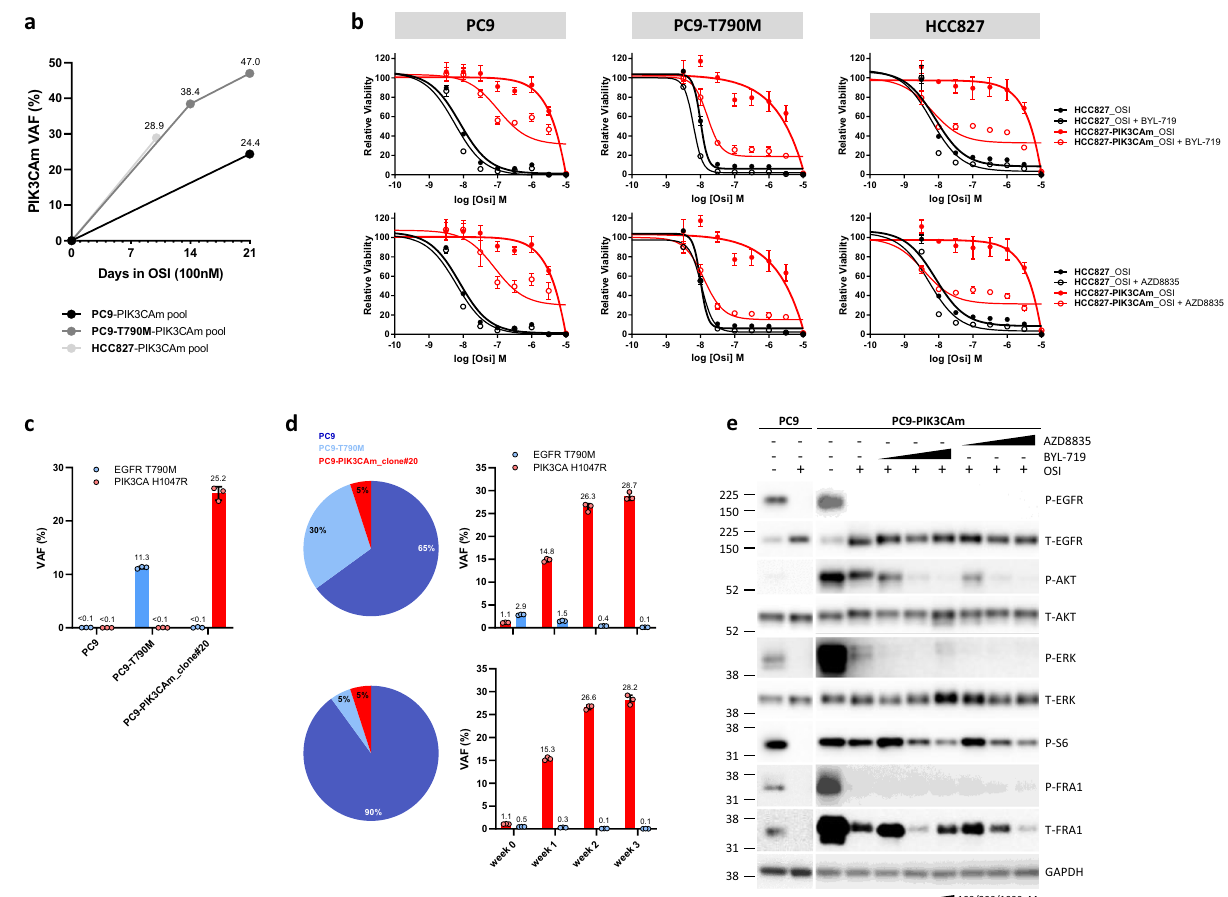
Fig. 5 In vitro functional analysis of the PIK3CA H1047R mutation (PIK3CAm) detected in multiple baseline plasmas from AURA3 patients. a Dynamics of PIK3CA H1047R VAF changes in individual CRISPRed cell lines treated with 100nM osimertinib for 2 – 3 weeks. The HCC827 – PIK3CAm pool was treated for 2 weeks (DNA analysis at day 10), the other two cell line pools were treated for 3 weeks. DNA from PC9 – PIK3CAm pool was assessed by NGS, the other two cell line pools were genotyped by ddPCR. PIK3CAm refers to PIK3CA H1047R. b Effect of osimertinib and 500nM PI3K pathway inhibitor (BYL-719, AZD8835) co-treatment in the PIK3CA H1047R mutant cell pool and PIK3CA WT parental cell lines grown in 2D monolayer. Parental cell lines PC9, PC9- T790M and HCC827 were tested. Representative experiments from three independent repeats are shown, error bars represent mean±SD from replicate wells. c EGFR T790M and PIK3CA H1047R genotyping in three cell line models used in a co-culture experiment: PC9, PC9-T790M (EGFR T790M VAF = 11.3 ±0.212%), PC9-PIK3CAm_clone#20 (PIK3CA H1047R VAF = 25.2±1.272%). Black lines and error bars represent the mean±SD VAF (%) from three independent ddPCR runs with optimised conditions for each ddPCR assay. The mean VAFs where values are not speci fi ed were <0.1%. d Pie charts (left panel) show the percentage of each cell line model in each of the two co-cultures tested in this experiment. The dynamics of EGFR T790M and PIK3CA H1047R VAF changes between weeks 0 – 3 of treatment with 160nM osimertinib in each co-culture is shown in the bar charts (right panel). Values and error bars represent the mean±SD VAF (%) from three independent experiments using optimised ddPCR assays. e Immunoblot analysis of PC9 parental cells and PC9 – PIK3CA – H1047R CRISPR cell pool grown in 2D monolayer and treated with vehicle (DMSO, marked as − ), osimertinib (OSI) alone or with a combination with BYL-719 or AZD8853. Treatment concentrations were the following: 100nM OSI, 100nM/300nM/1000nM BYL-719 or AZD8853. Immunoblot analysis was performed on a cellular extract of cells treated for 4h by indicated compounds and concentrations. Immunoblotting analysis has been repeated at least once for each treatment condition. Source data are provided as a Source Data fi